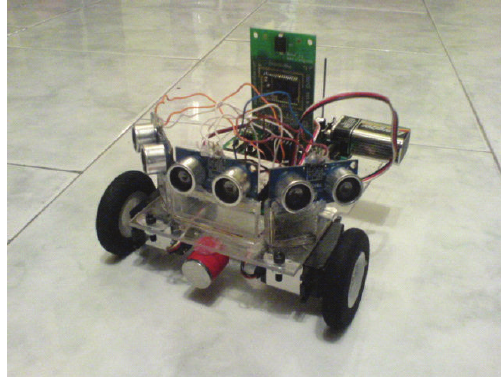
Figure 16: Implementation of the new structural design.